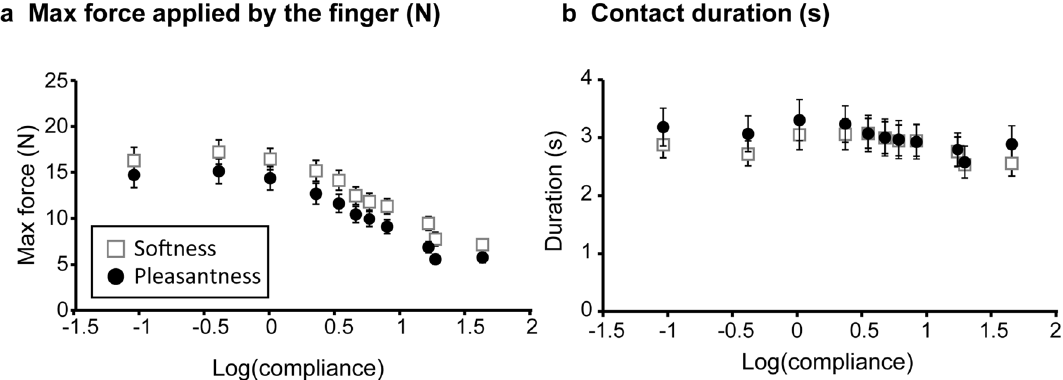
Figure 5. Maximum force and contact duration. Patterns of maximum force applied by the finger and contact duration plotted as a function of log 10 (compliance). Each data point indicates the mean ± standard error of the mean (SEM) of 24